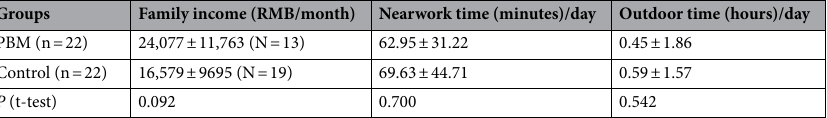
Table 4. Results of questionnaires from the two groups. PBM photobiomodulation therapy, Control single vision spectacles group, P value was decided by the independent